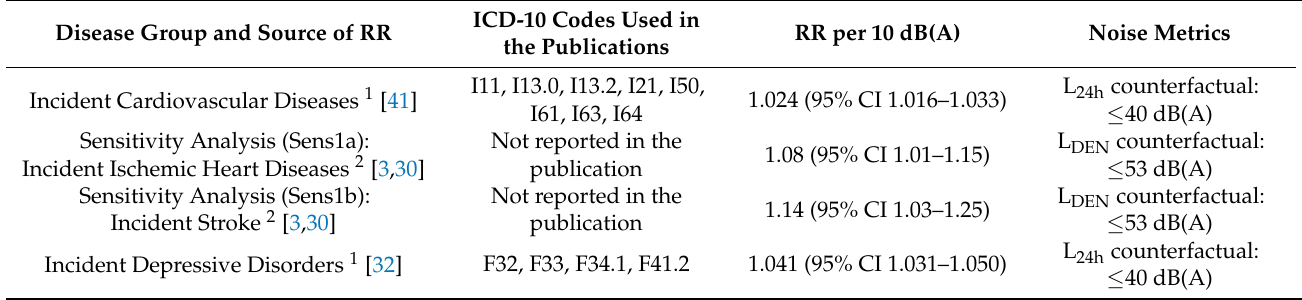
Table 1. Relative risks for PAF calculations and the publication